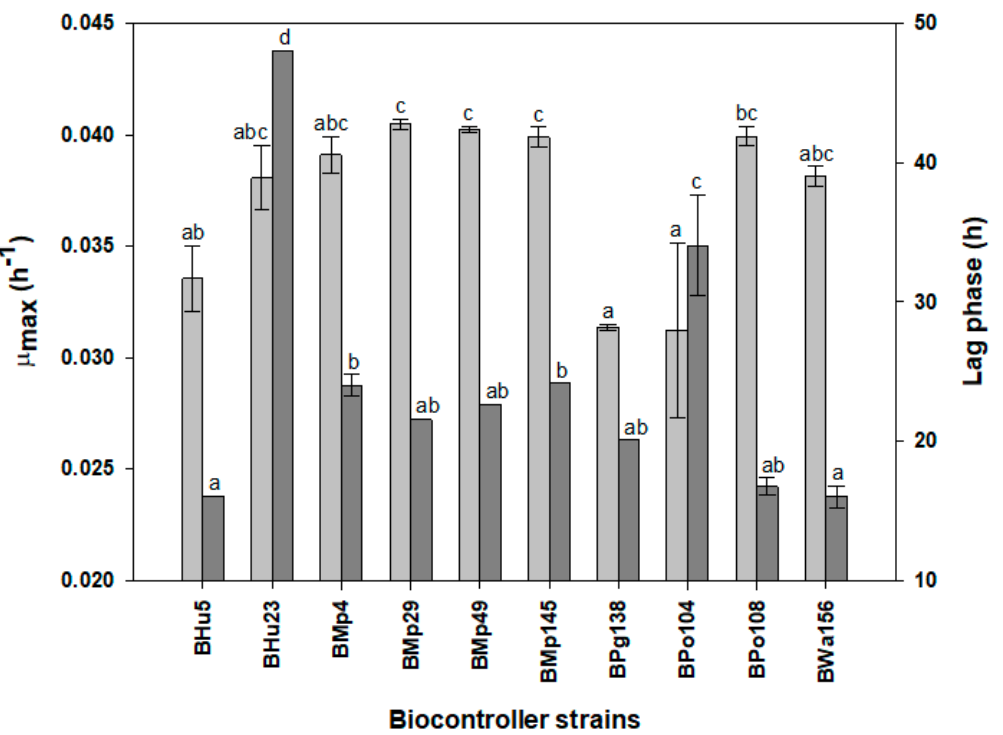
Figure 1. Specific growth rate (light grey) and lag phase (dark grey) of the non- Saccharomyces yeasts assayed. Rates are means with standard deviation ( n = 3). Values with different letters are assayed. Rates are means with standard deviation ( n = 3). Values with di ff erent letters are significantly significantly different. di ff